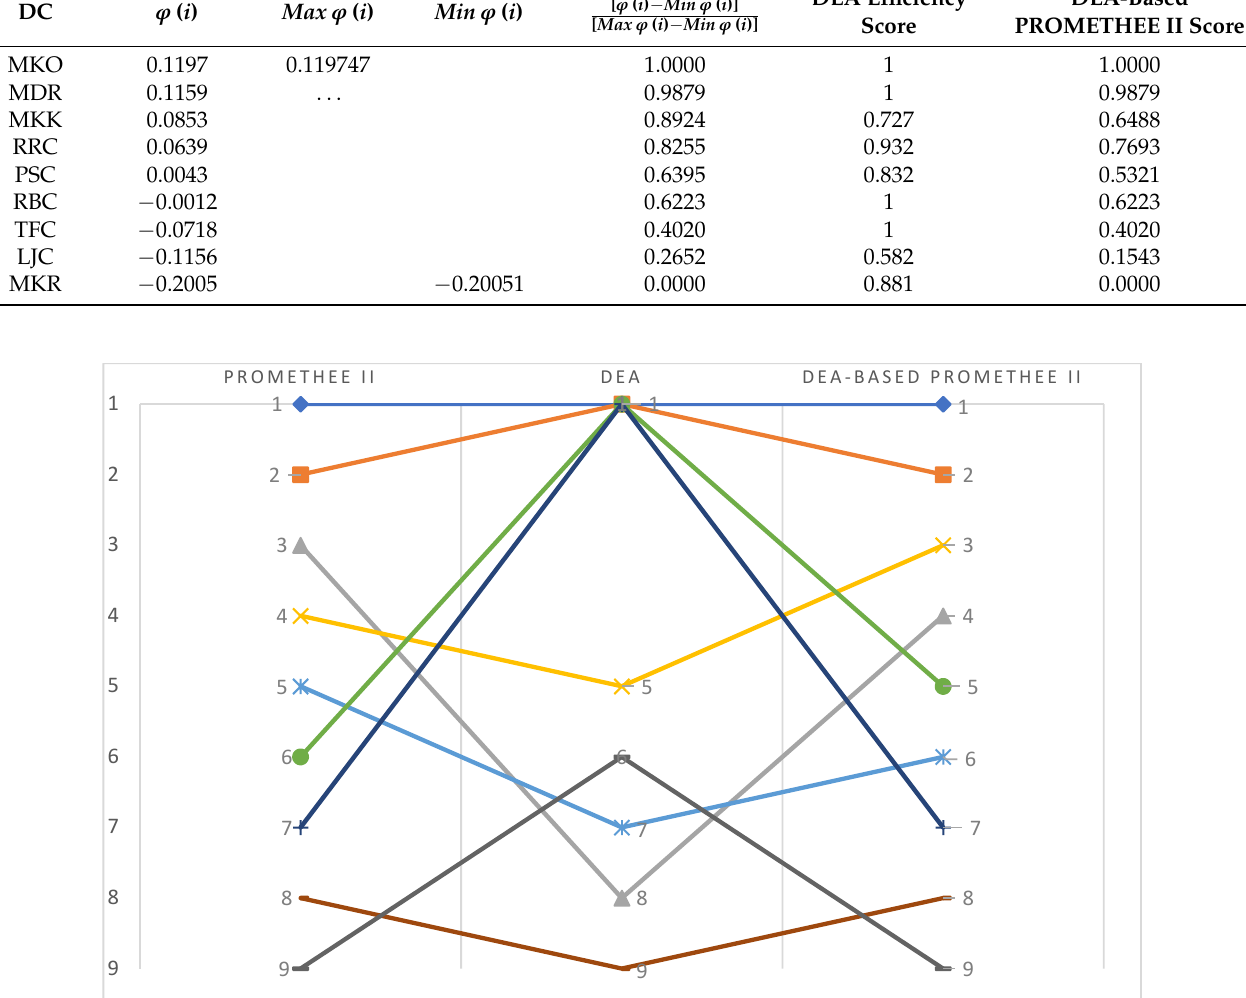
Table 4. Normalized PROMETHEE II results and the final DEA-based PROMETHEE II score.